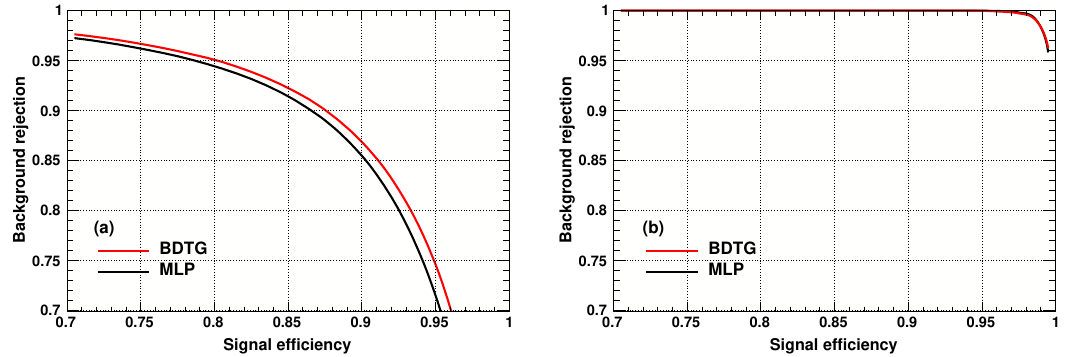
Figure 12 . Background rejection versus signal efficiency from BDTG (red) and MLP (black) at √ s = 14 TeV, for the scenarios m N = 150 GeV (left) and 500 GeV